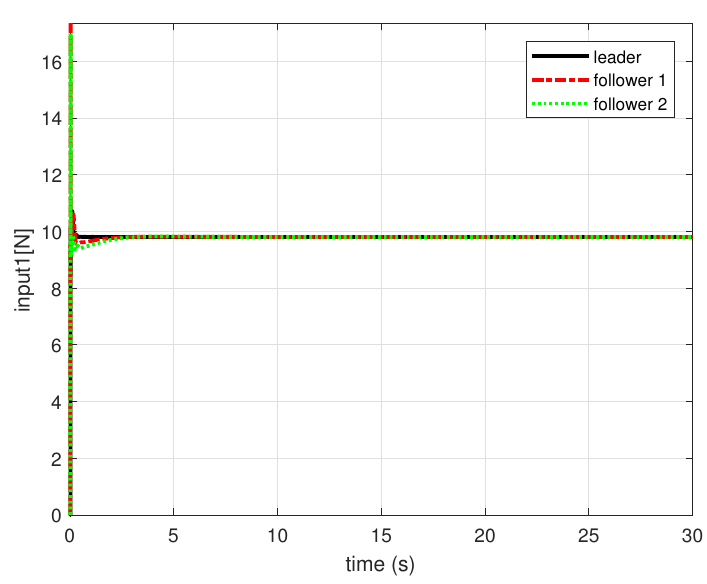
Figure 8. The control input for the altitude of the leader and follower quadrotors.